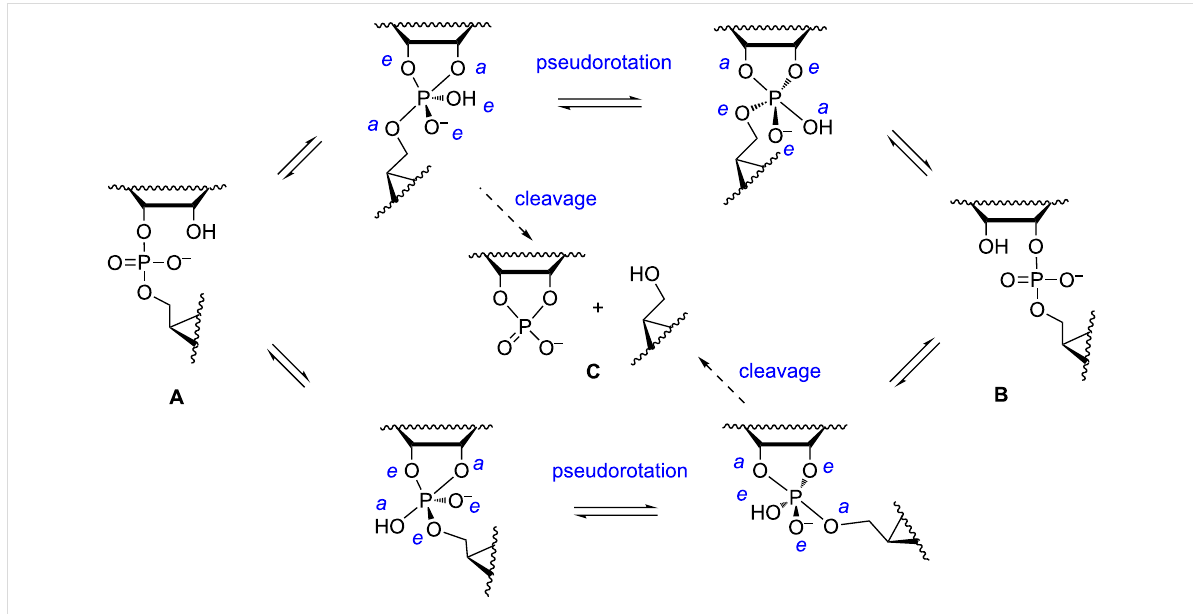
Scheme 1: pH- and buffer-independent cleavage and isomerization of RNA phosphodiester linkages. Observed first-order rate constant for the cleavage ( k cl ) refers to transesterification of A + B to C , and observed rate constant for isomerization ( k is ) to mutual isomerization of A and B , the values for the forward and reverse reactions being almost equal.